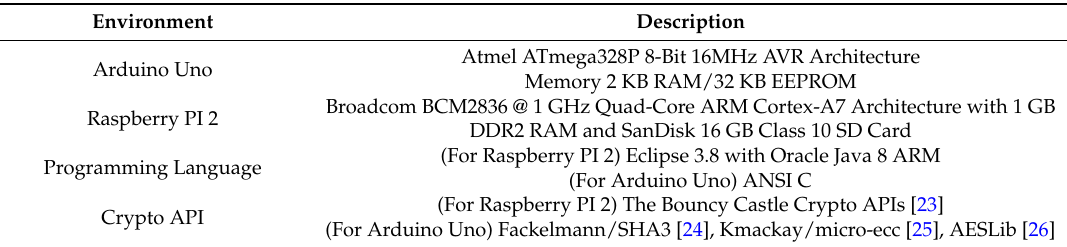
Table 1. Implementation